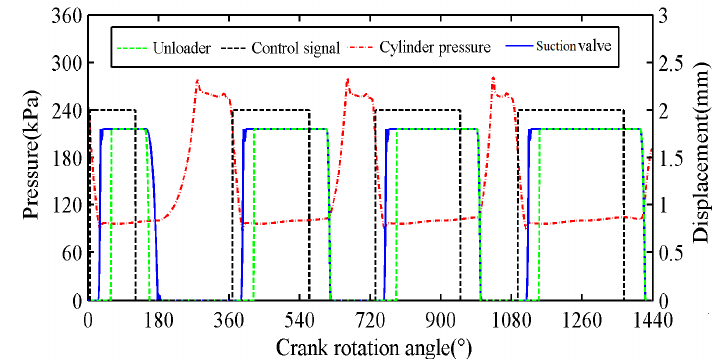
Figure 8. Dynamic process under different control signals.